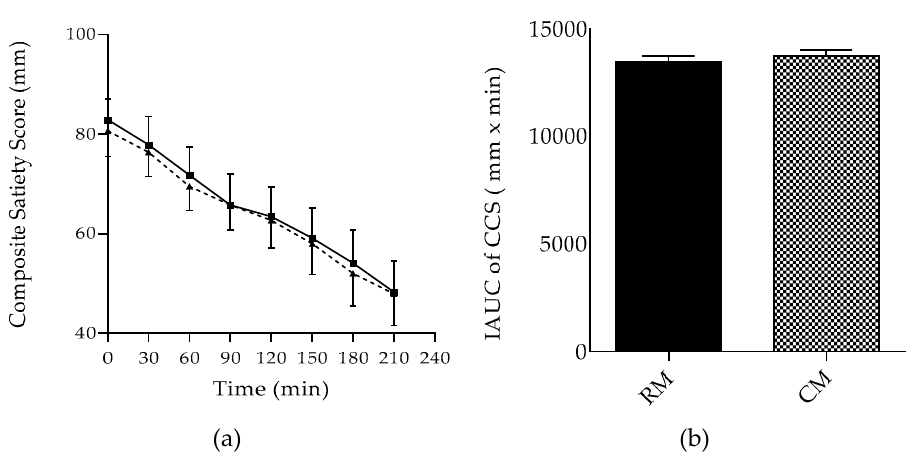
Figure 5. Composite Satiety Score (CSS) changes ( a ) following the ingestion of RM and CM in healthy adult females. i AUC of CSS ( b ) following the ingestion of RM and CM meals. Data are expressed as mean values ± SEM. RM: Regular Mankoushe --- ---; CM: Chickpeas Mankoushe ― ― ; M: Meal; T: Time.